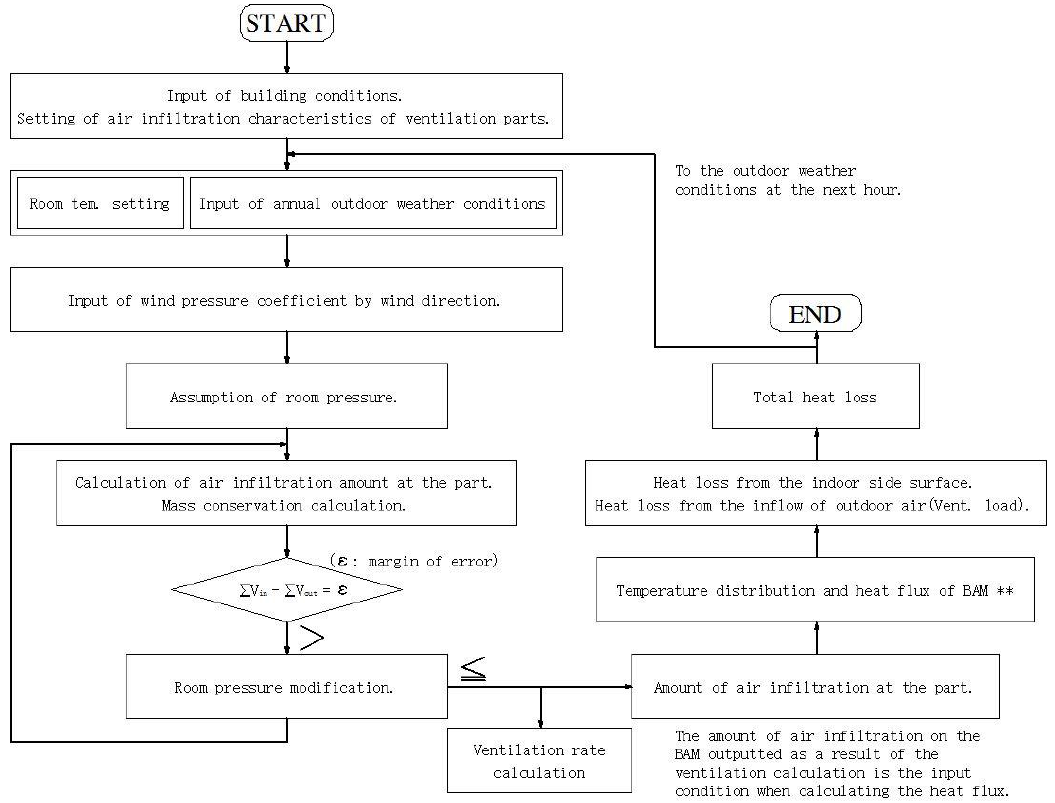
Figure 9. Combination of BAM design and ventilation rate prediction